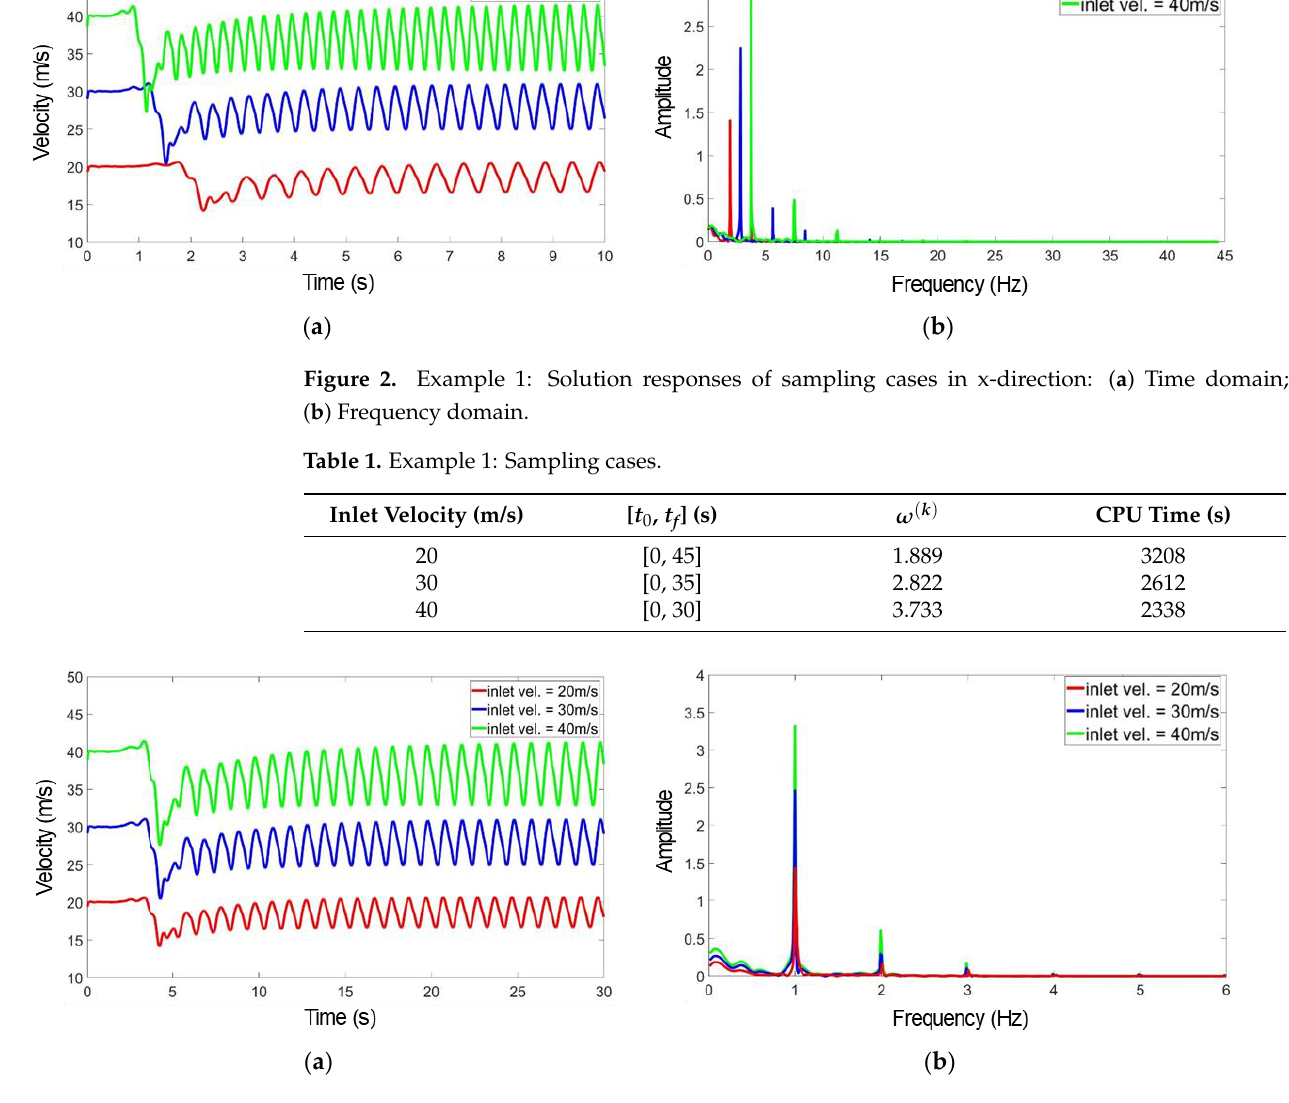
Figure 3. Example 1: Adjusted solution responses in x-direction: ( a ) Virtual time domain; ( b ) Virtual frequency domains. Table 1. Example 1: Sampling cases.